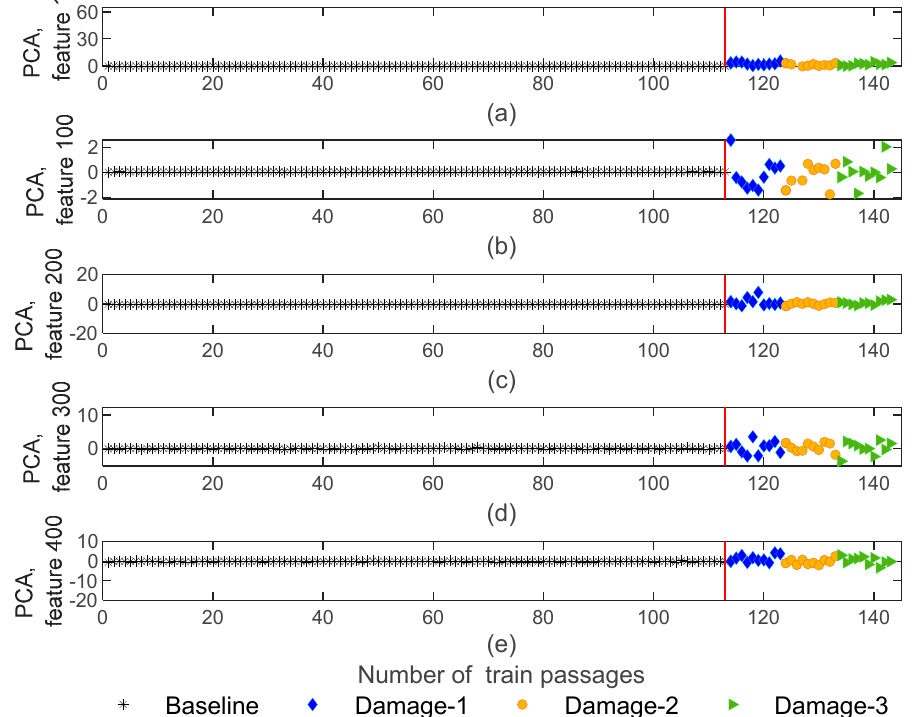
Figure 14. CWT—feature normalization for all 143 baseline and damage scenarios for accelerometer 3: ( a ) PCA for feature 1, ( b ) PCA for feature 100, ( c ) PCA for feature 200, ( d ) PCA for feature 300, ( e ) PCA for feature 400.